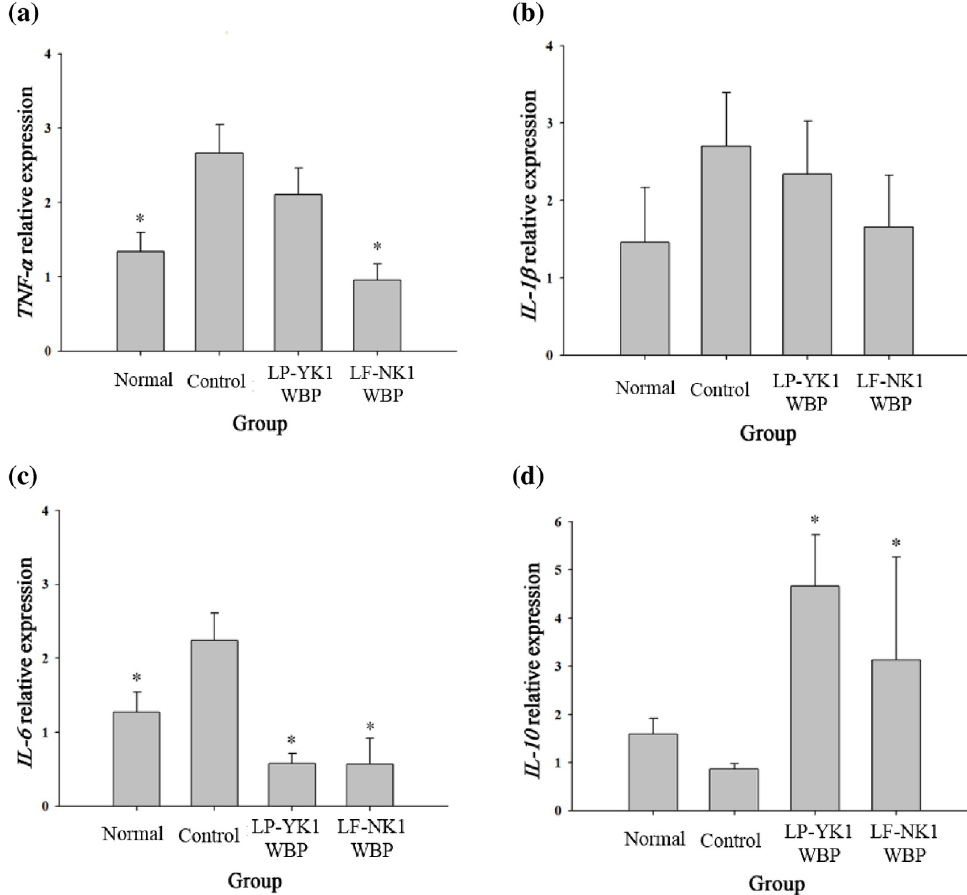
Fig 2. Relative expression of inflammatory cytokines in gingival tissue after treatment with fermented whey bioconversion products (WBPs) for 8 weeks. (a) TNF- α (b) IL-1 β (c) IL-6 (d) IL-10 . Normal; Administration of phosphate buffered saline (PBS) without inducing periodontitis, Control; Administration of PBS after inducing periodontitis, LP-YK1 WBP; Administration of WBPs by L . plantarum SMFM2017-YK1 after inducing periodontitis, LF-NK1 WBP; Administration of WBPs by L . fermentum SMFM2017-NK1 after inducing periodontitis. � Statistically significant, compared to control group by pairwise Student’s t -test ( p <